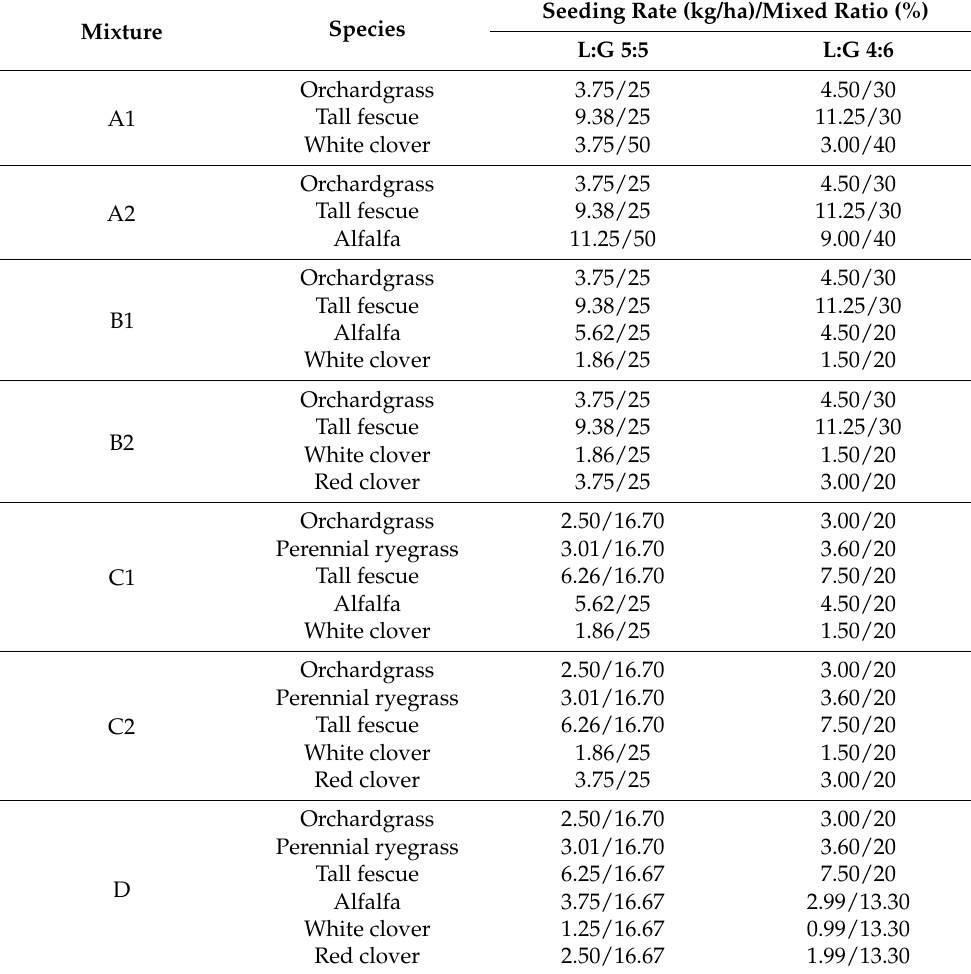
Table 2. Seeding rates of legume and grass species in selected mixtures under two legume-grass seeding